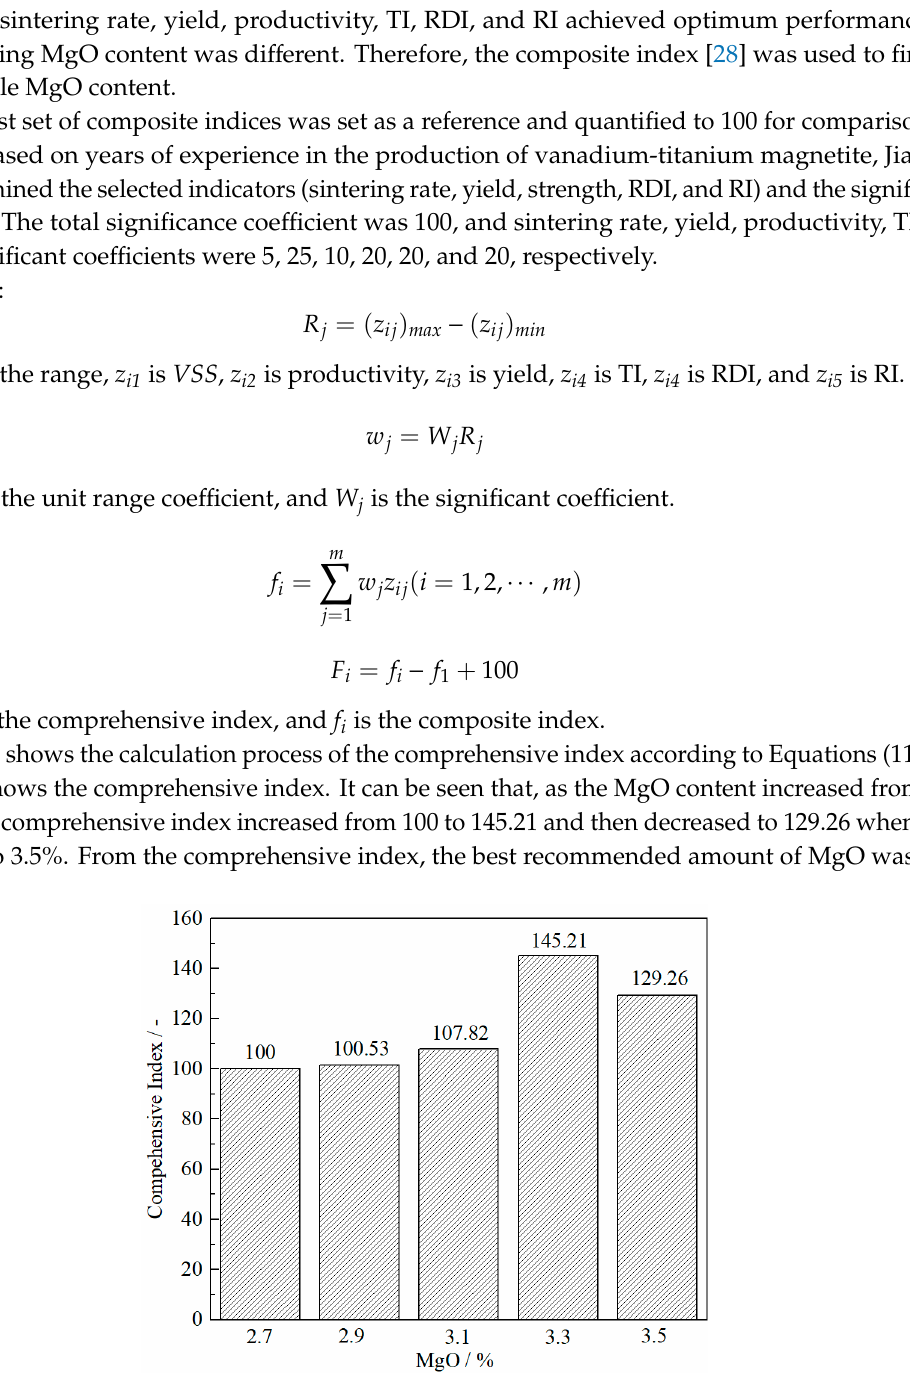
Figure 11. Effect of MgO content on comprehensive index of HCVTM. Figure 11. E ff ect of MgO content on comprehensive index of